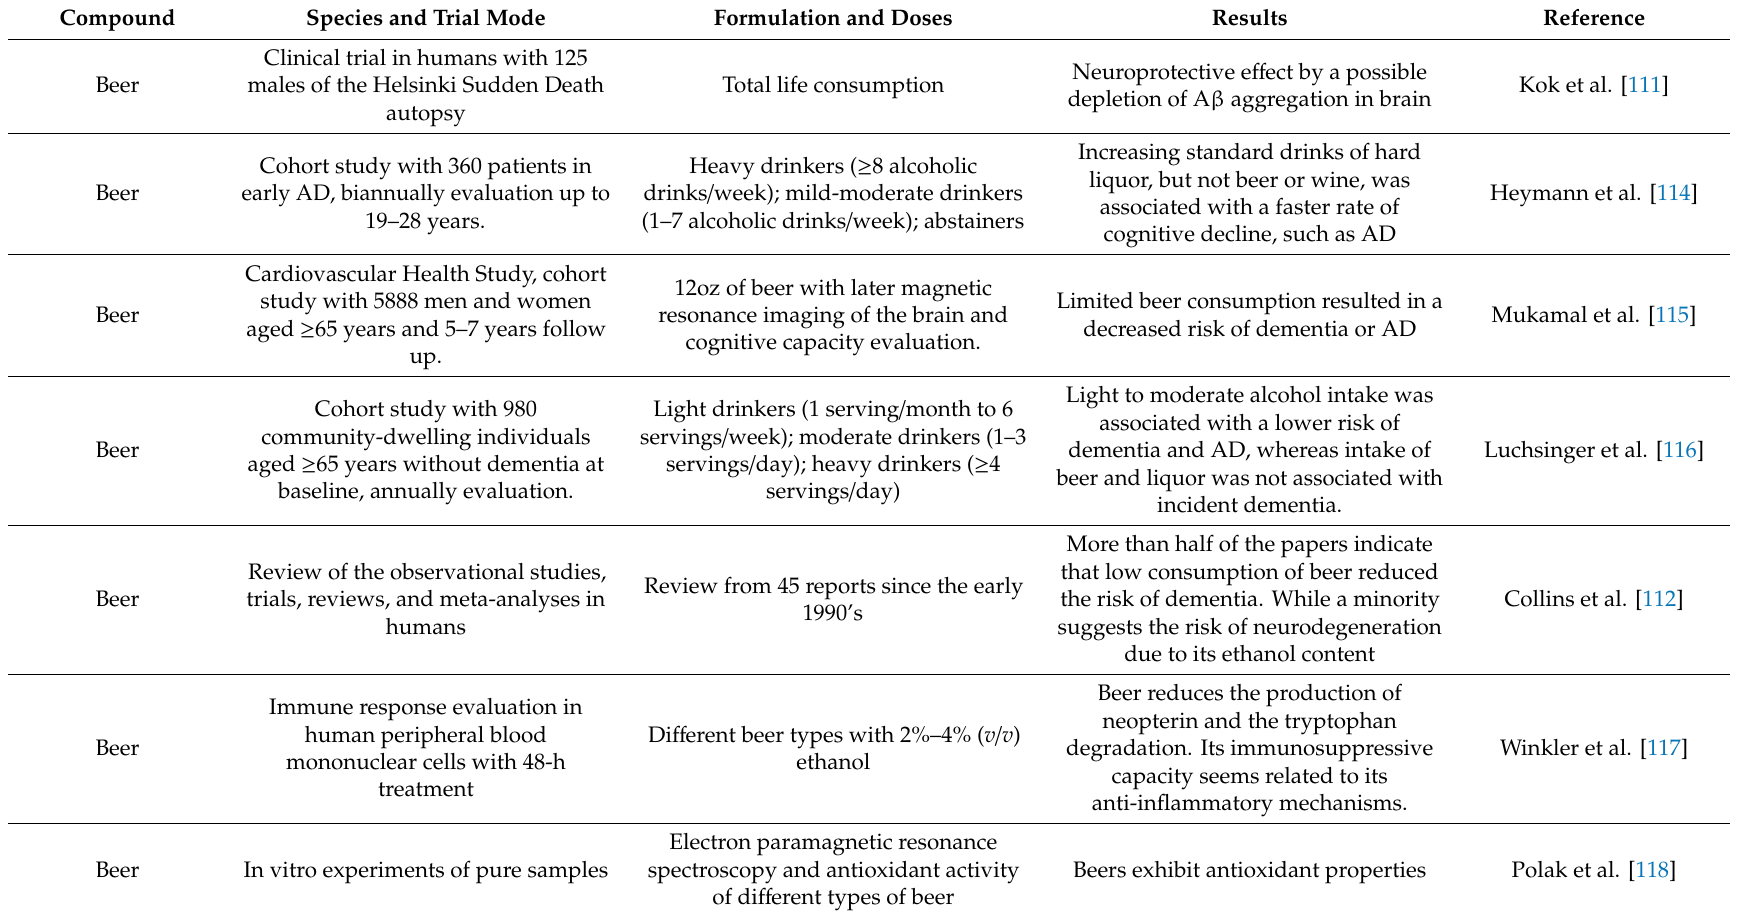
Table 4. Main in vivo and in vitro studies of beer and its compounds’ activity on neurodegenerative